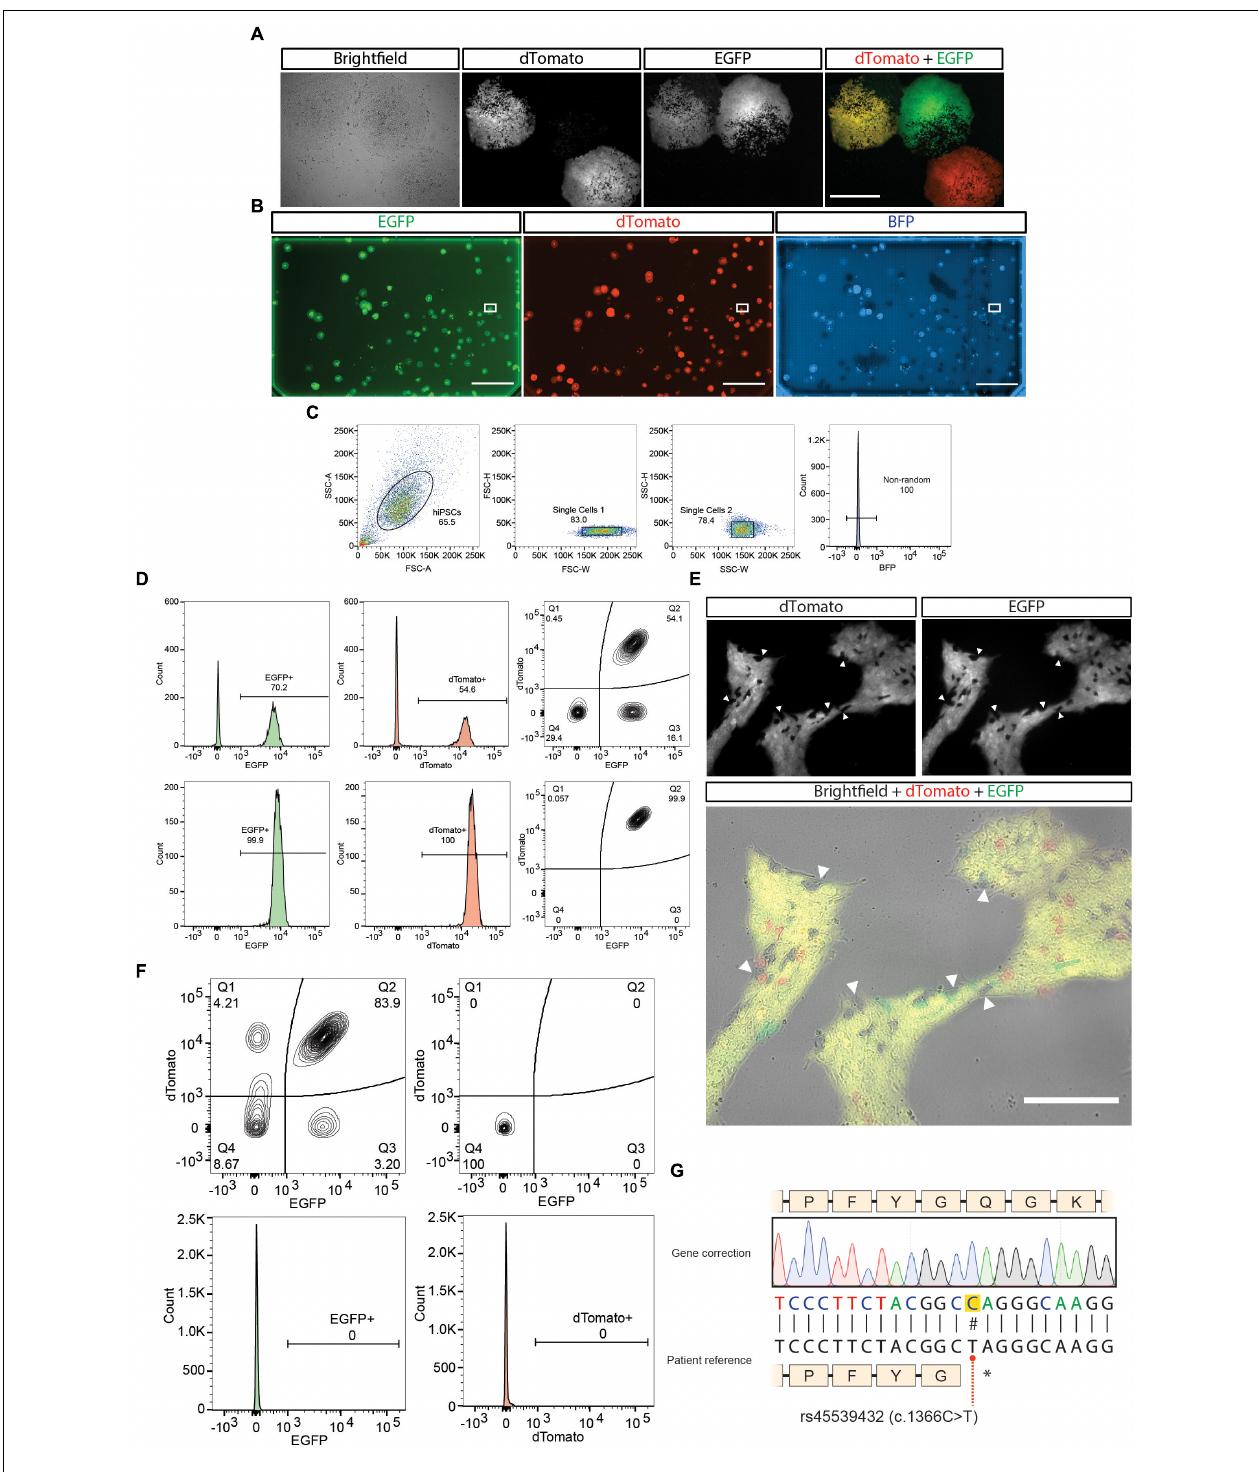
FIGURE 4 | Cell culture work of the gene correction example. (A) Representative images of hiPSCs colonies expressing the different possible outcomes of gene modification. Scale bar = 500 µ m. (B) A one-well plate screened for detecting correct biallelic targeting (dTomato+/EGFP+/BFP-). Bounding box shows selected isolated region. Scale bar = 2 cm. (C) Single cell isolation gating strategy performed, plus exclusion of BFP+ cells from an expanded culture derived from the selected region in (B) . (D) First (upper panel) and second (lower panel) purity sort for purifying dTomato+/EGFP+/BFP- cells. (E) Removal of the positive selection module after treatment with transposase. (F) First sort after transposase induction (top left panel). Last purity sort before sequencing ( n = 3) (top right panel and bottom panels). (G) Sequencing results of the gene correction of the patient line.